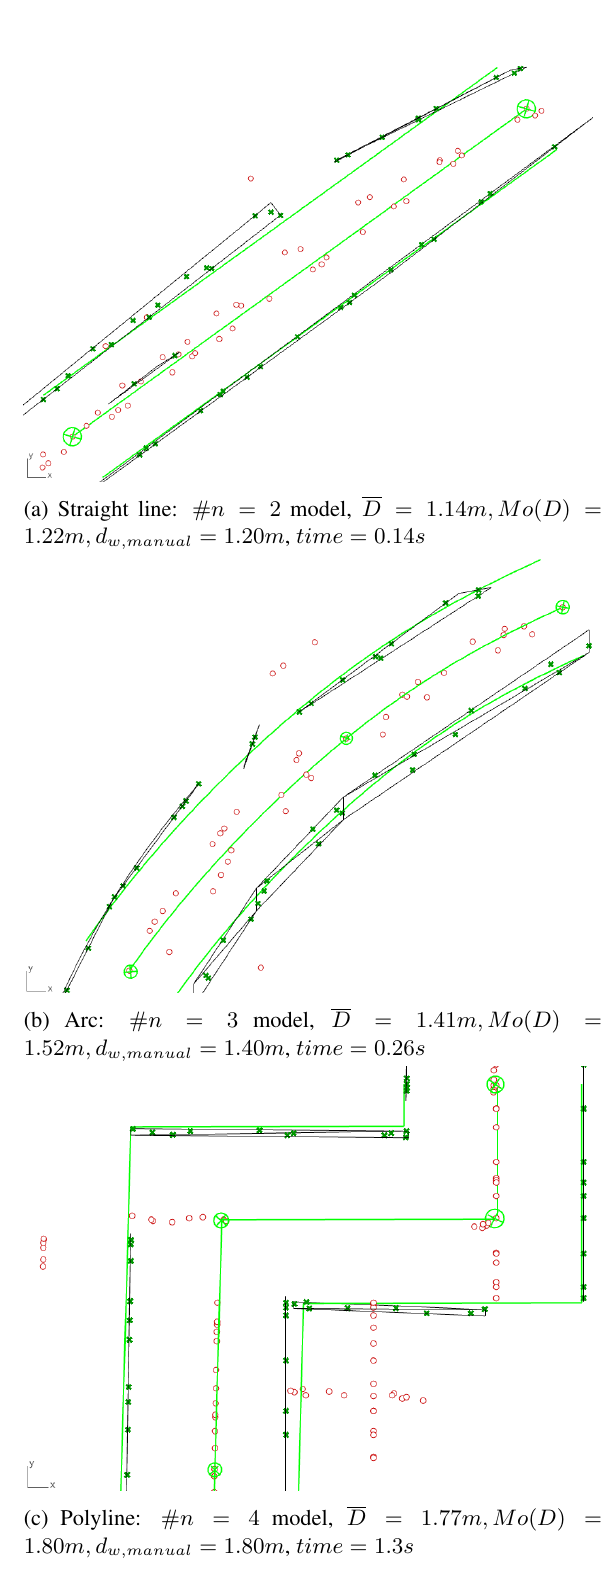
Figure 4: Model fitting of ψ ( N ) (green lines) based on C (red dots). (cid:107) ψ ( N ) − P }(cid:107) is computed between P (green dots) and C given 0 . 5 d w (offsetted green